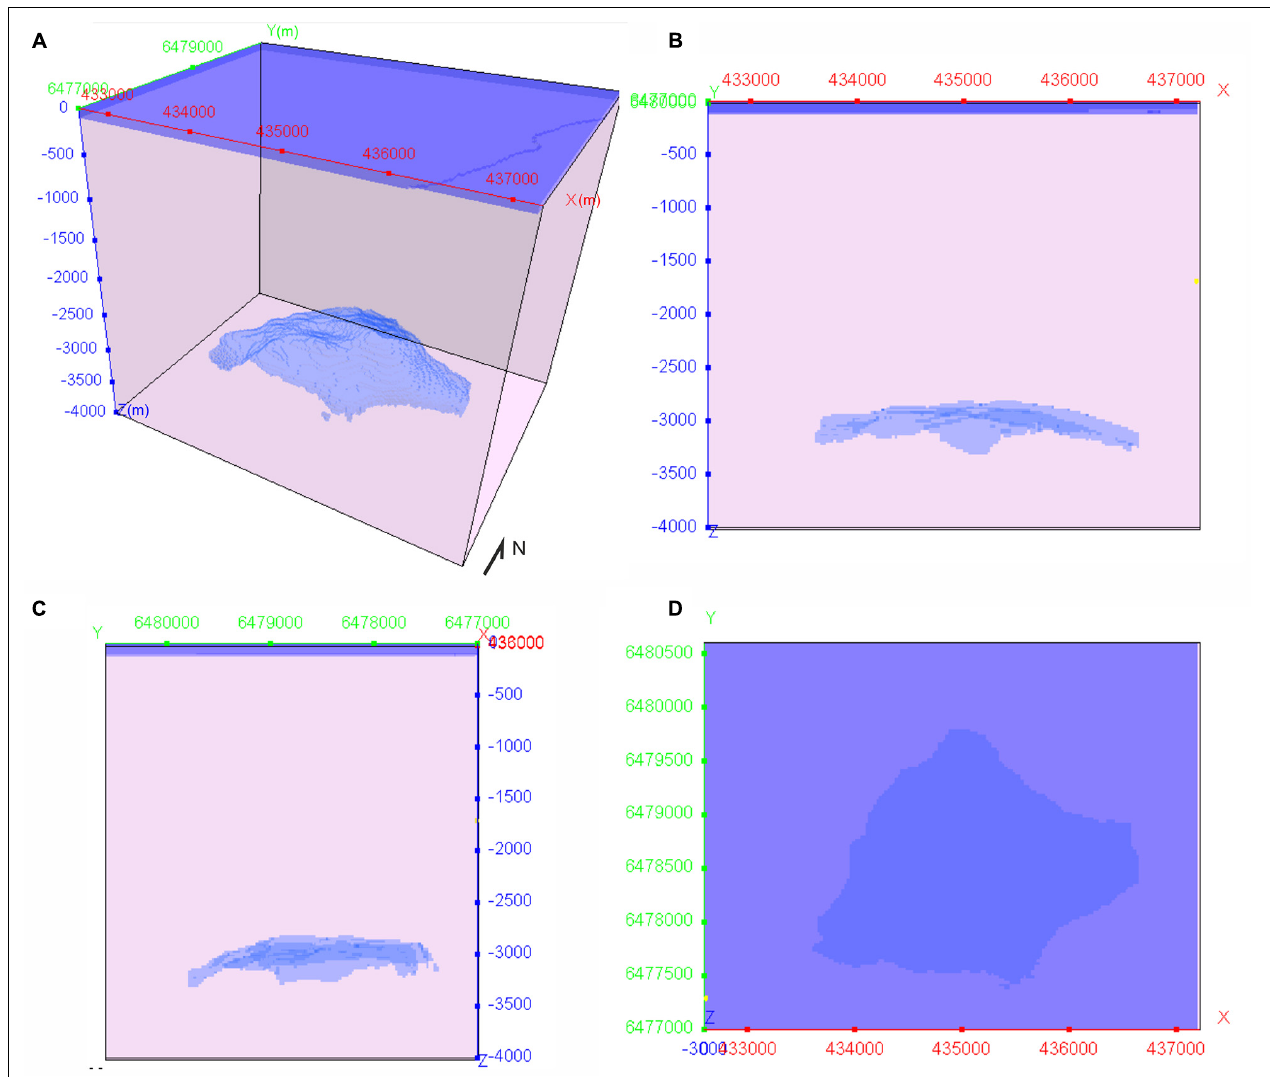
FIGURE 2 | Geometries of the Hugin reservoir and sea water (blue volumes) within the entire model. (A) Perspective, (B) northward, (C) eastward and (D) downward view of the mesh. All scales are in meters. This mesh was used for the pre- and post-production 3D forward models. Cell size is 25 m × 25 m × 25 m. Y axis locates geographic north. Coordinates are in the same system as in Figure 1